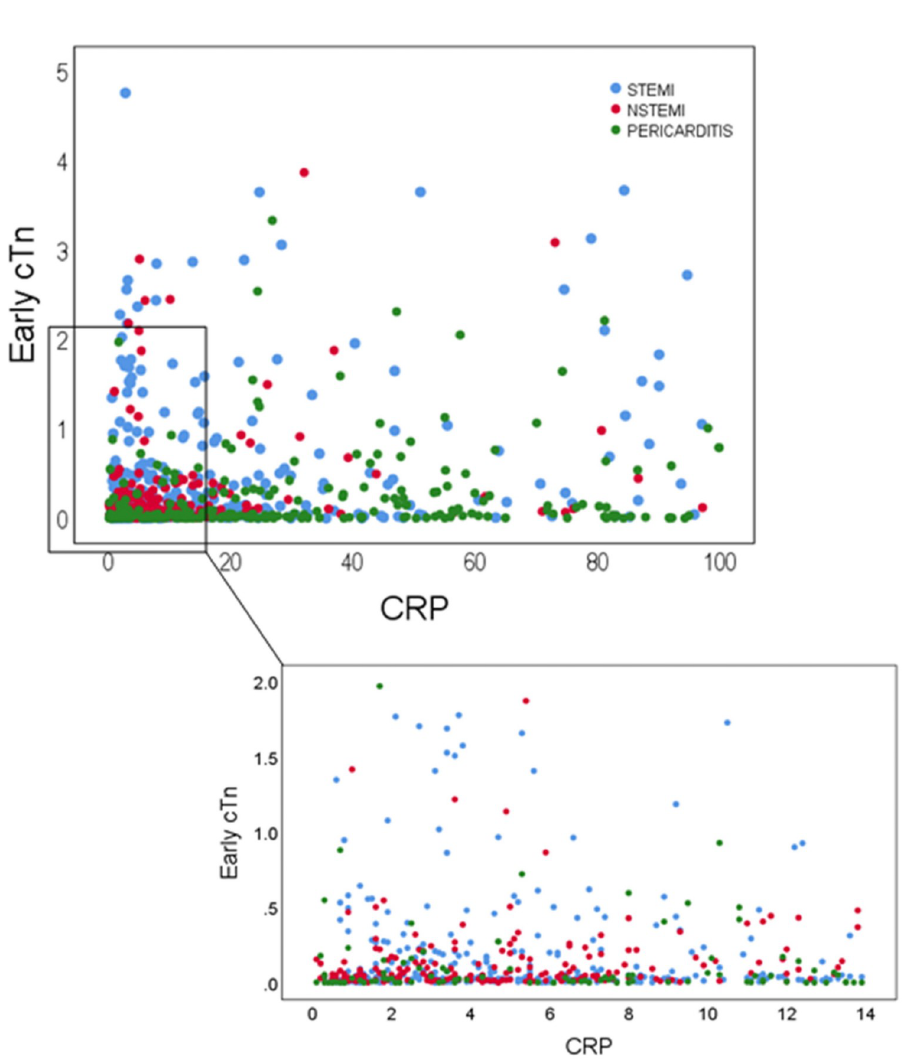
STEMI patients localize typically along and closer to the troponin axis (blue circles) generally characterized by lower CRP values. Inset displays magnification of point scatter adjacent to origin. Red points representing NSTEMI patients are mostly characterized as expected by low CRP and troponin levels. cTn- cardiac troponin; CRP- C-reactive protein; STEMI- ST-elevation myocardial infarction; NSTEMI- Non